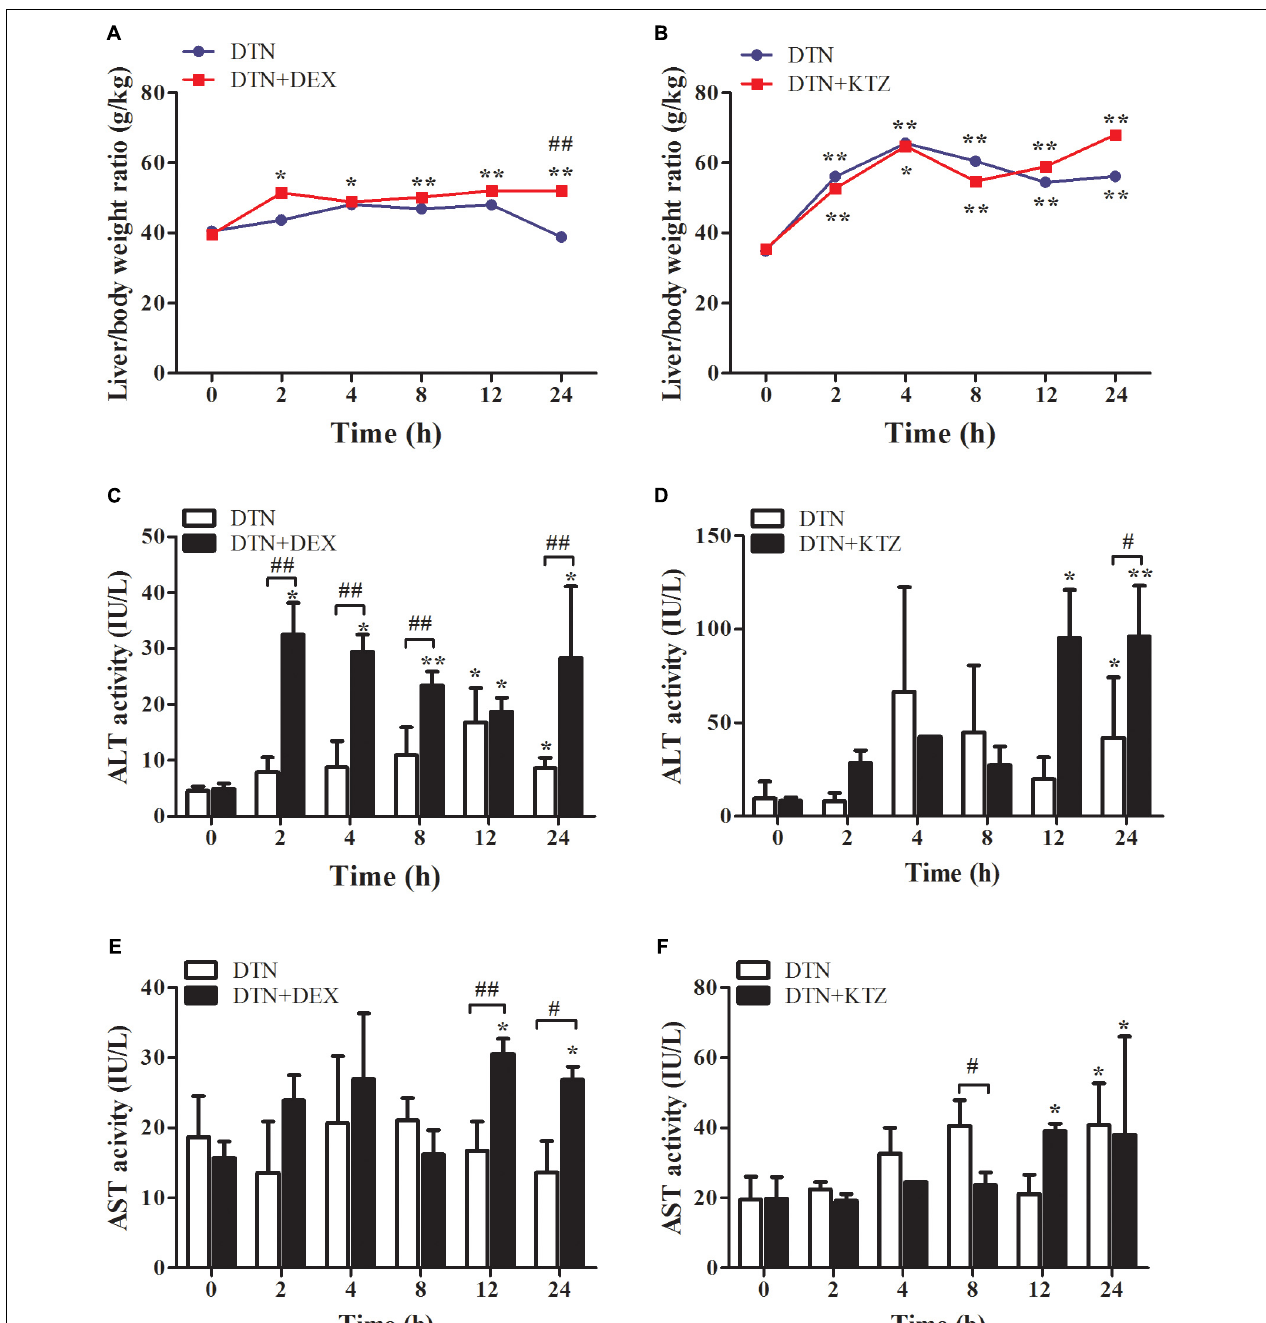
FIGURE 8 | The effect of induction and inhibition of CYP3A4 on DTN-induced liver injury in mice. (A,C,E) Liver/body weight ratio, ALT and AST activities after exposure to DTN (a single dose of 640 mg/kg) in mice pretreated with DEX. (B,D,F) Liver/body weight ratio, ALT and AST activities after exposure to DTN (320 mg/kg for 4 days and 640 mg/kg on the 5th day) in mice pretreated with KTZ. Values are represented as mean ± SD ( n = 4). ∗ p < 0.05, ∗∗ p < 0.01 vs. control group; # p < 0.05, ## p < 0.01 vs. DTN